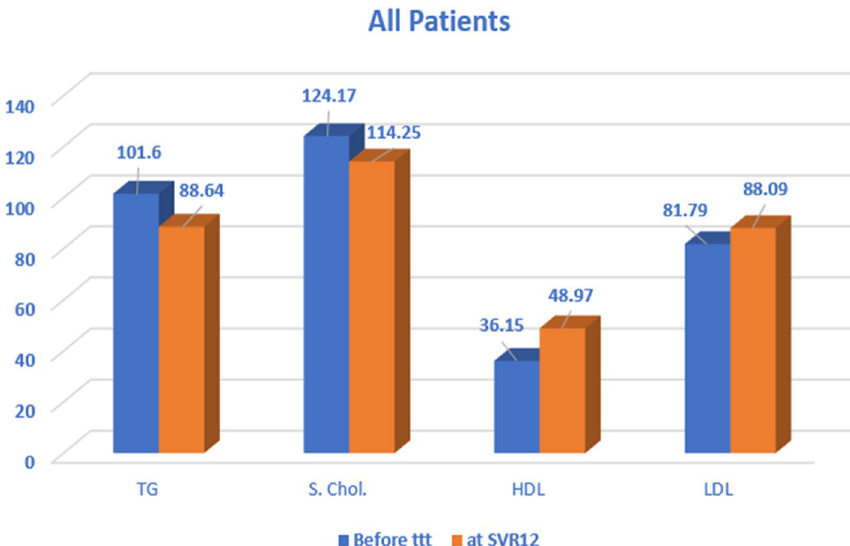
Fig. 4 Comparison between the studied groups regarding NAFLD score at